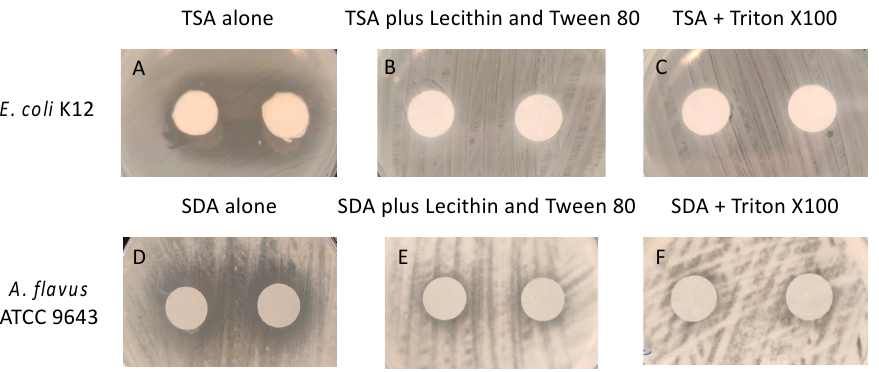
Figure 2. Demonstration of neutralization of active ingredients (essential oils) in the gel. ( A , D ) in the absencde of neutralisers, ( B – F ) in the presence of neutralisers. TSA = tryptic soy agar; SDA = Sabouraud’s dextrose agar.